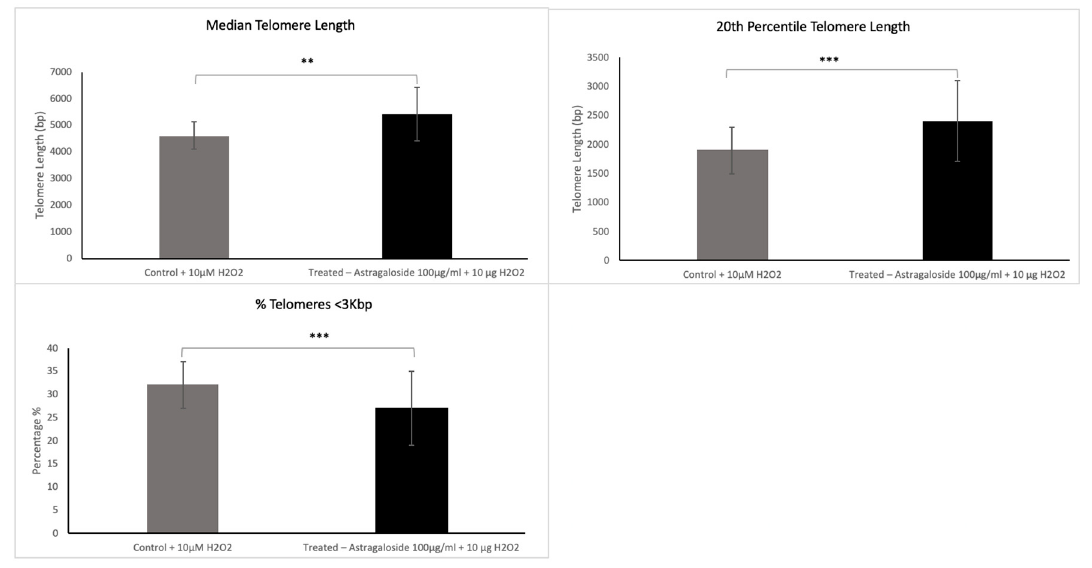
Figure 2. Bar chart comparison of control vs. treated (astragaloside 100 μ g/mL) samples after four weeks of in vitro expansion and under oxidative conditions. The variables compared are median telomere length, 20th percentile length, and the % of telomeres <3 Kbp. Significant differences are indicated: **— p < 0.01, ***— p < 0.001.